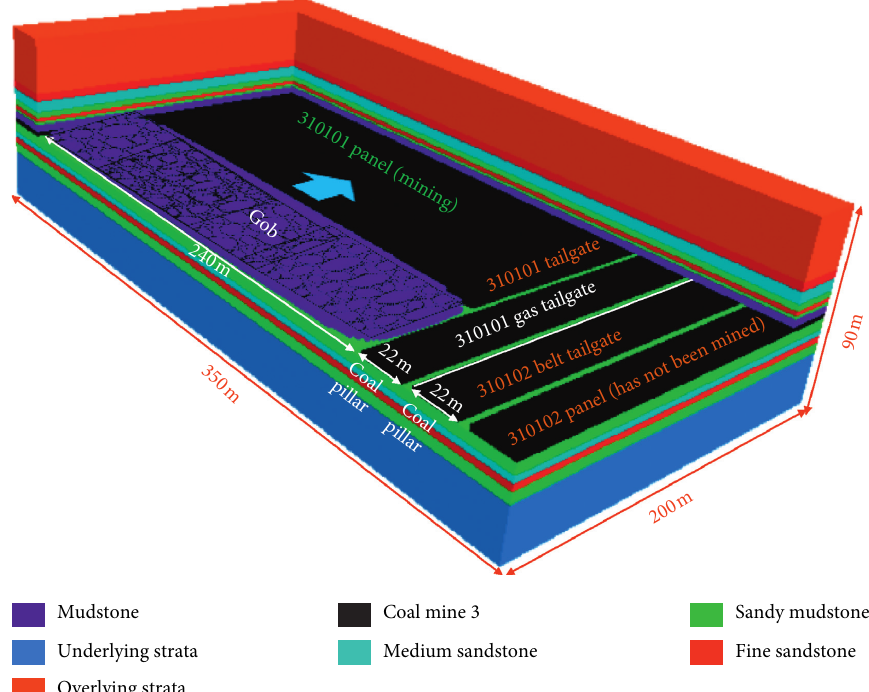
Figure 6: Numerical model diagram.